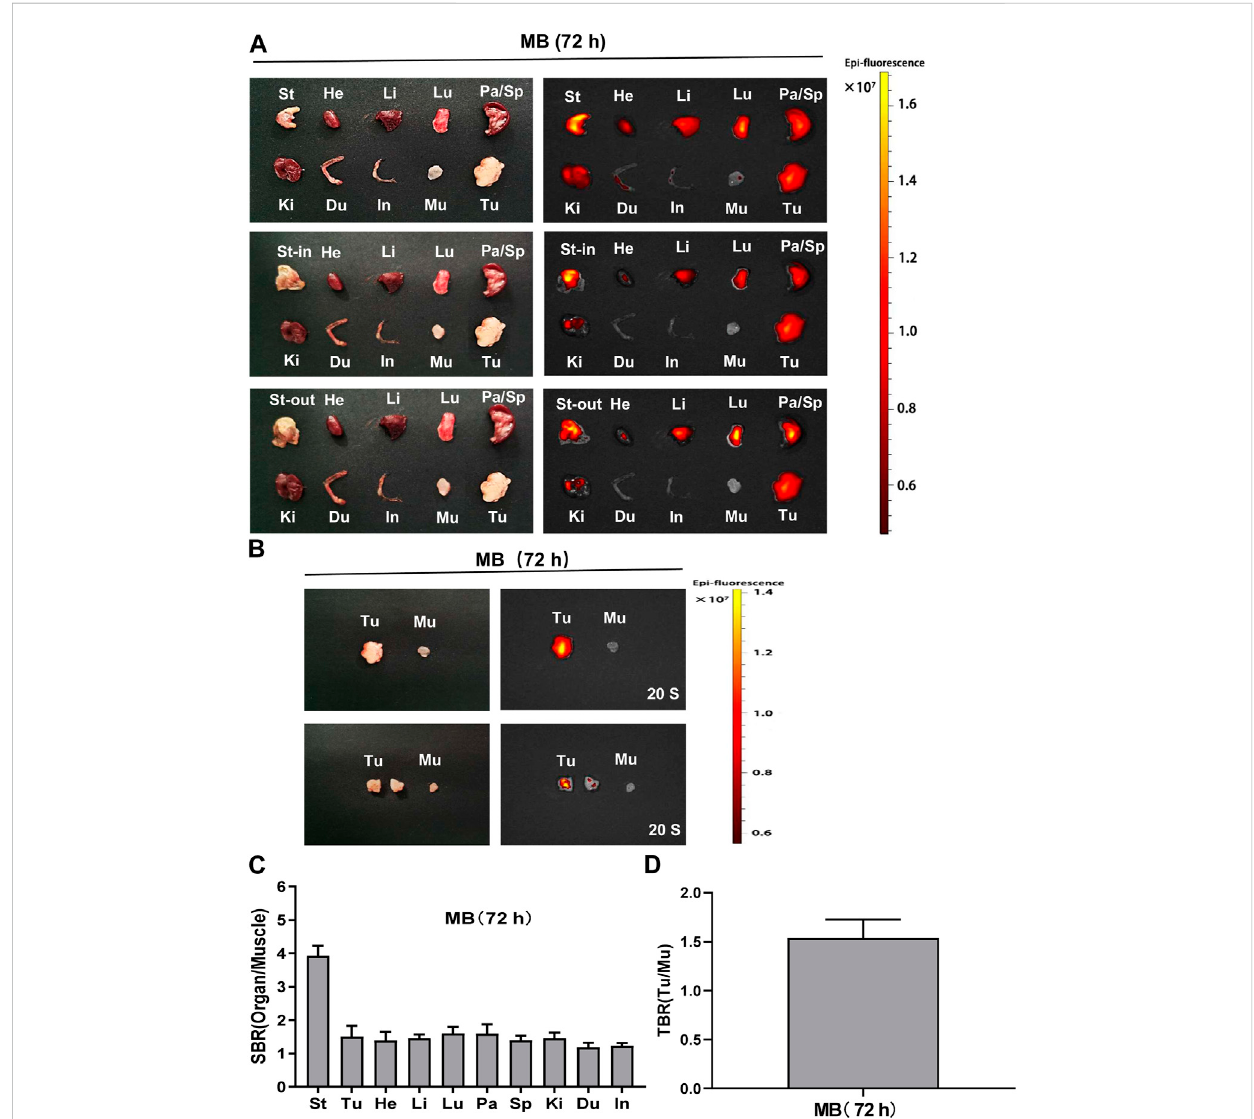
FIGURE 7 Organ and tumor speci fi city of MB at 72 h post-injection. MB was injected intravenously into subcutaneous gastric tumor-bearing nude mice, and theNIR fl uorescence signals wereobserved at72 hpost-injection underthe NIR imaging system. (A) NIR imaging of resected major organs and tumor at 72 h post-injection of MB. (B) NIR imaging of resected tumor at 72 h post-injection of MB. (C) SBR of each organ against muscle. SBR was calculated by comparing thesignals ofmajor organs againstthesurrounding muscle. (D) TBR ofresectedtumors. TBR wascalculatedby comparing thesignals of the tumor against the surrounding muscle. Abbreviations are Du, duodenum; He, Heart; In, intestine; Ki, kidneys; Li, liver; Lu, lungs; Mu, muscle; Pa, pancreas; Sp, spleen; St, stomach; St-in, stomach-in; St-out, stomach-out; Tu, tumor. Each sample used three mice. Error bars show mean ±